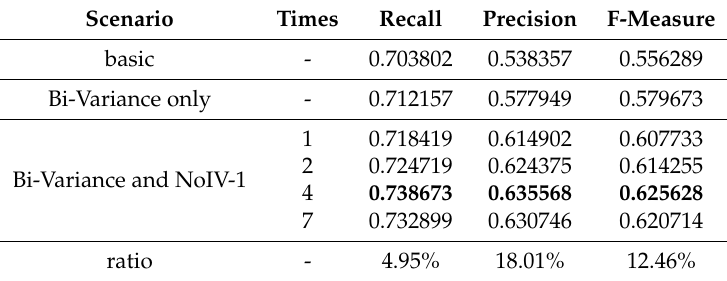
Table 3. Results of PBASexecuted on three scenarios.